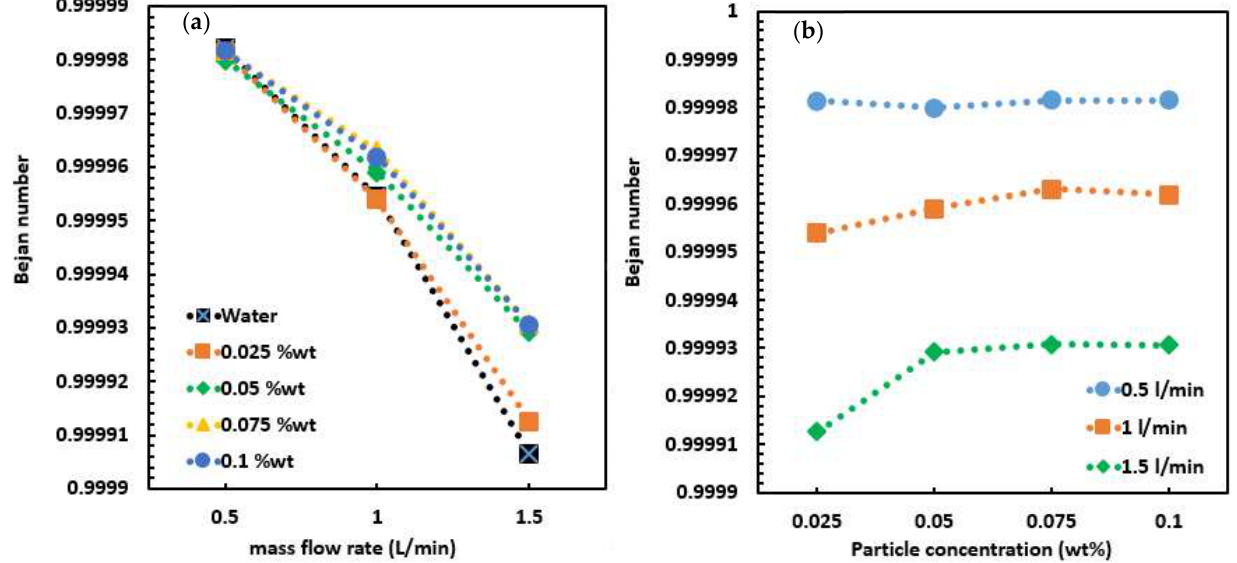
Figure 6. ( a ) Effect of volumetric flow rate on Bejan number and ( b ) Effect of nanofluid concentration (wt%) on Bejan